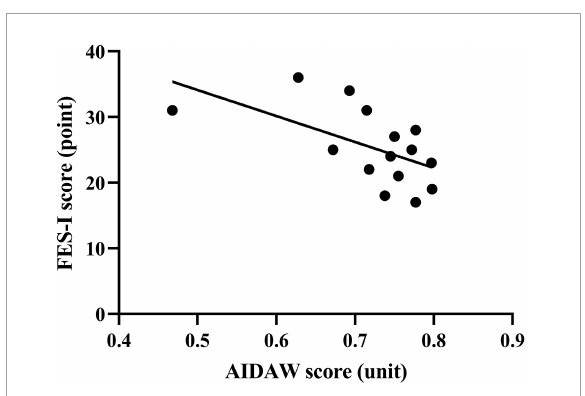
FIGURE6 Correlation analysis of the AIDAW and FES-I scores in the older group (rho =